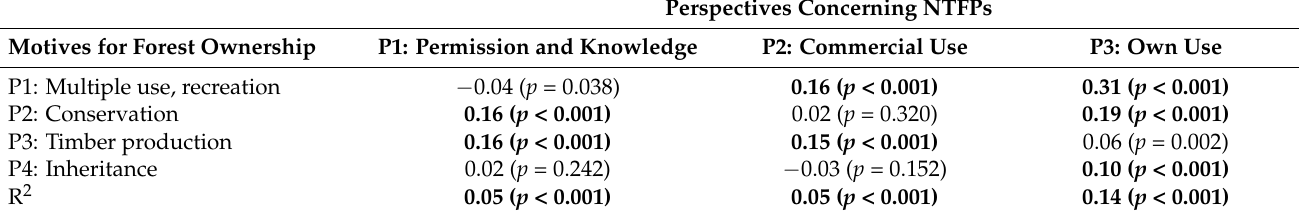
Table 7. Relationships among the PC score variables on forest owners’ motives for forest ownership and perspectives concerning NTFPs (n = 2114). Average squared canonical correlation = 0.08; Cohen’s set correlation R 2 = 0.23. Statistically highly significant coefficients are in bold ( p < 0.001). Perspectives Concerning